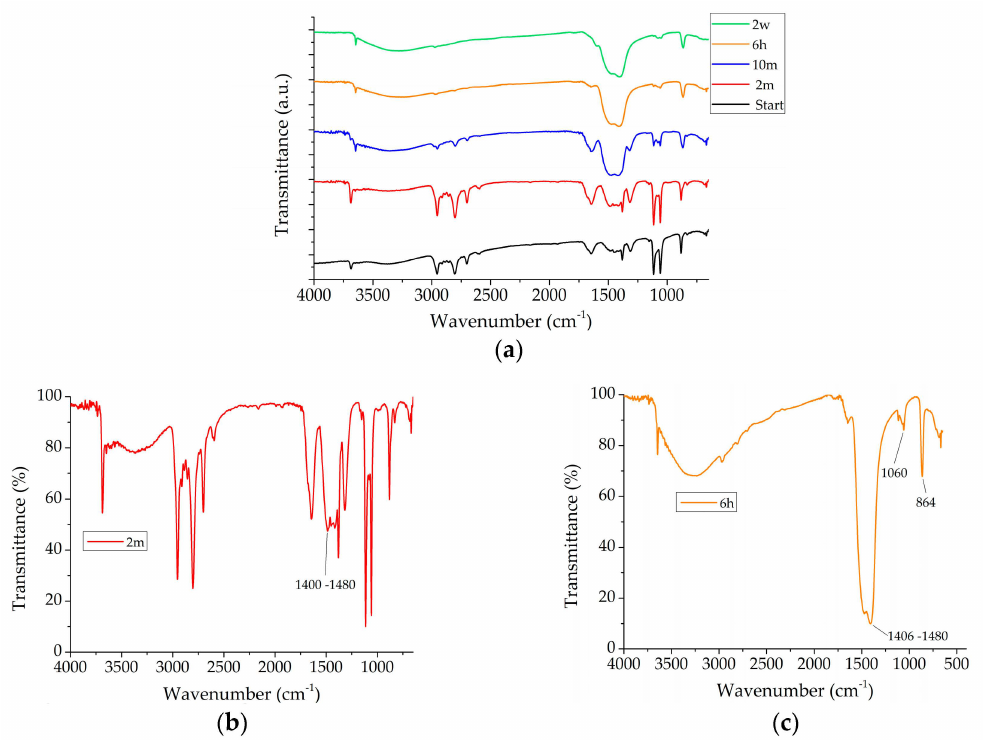
Figure 1. µ FT-IR spectra showing kinetic process of Ca(OEt) 2 : ( a ) entire process; ( b ) spectrum acquired after two minutes; ( c ) spectrum acquired after six hours. Time intervals: start, beginning of the reaction; 2 m, two minutes; 10 m, ten minutes; 6 h, six hours; 2 w, two weeks.